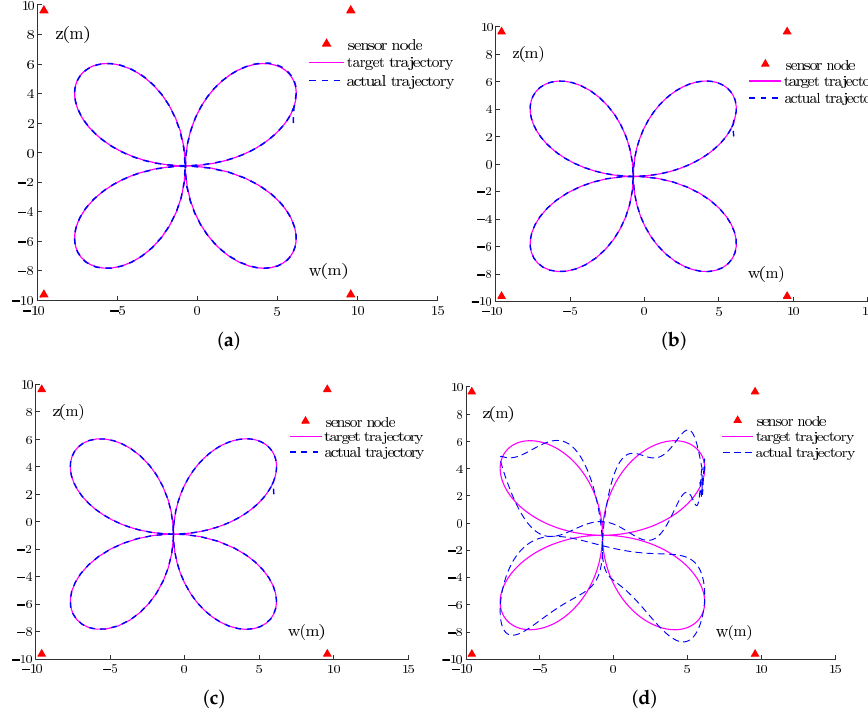
Figure 8. The target trajectories and actual trajectories by the two FPDP models, VPDP model and the pseudo-inverse method with noise η l ( t ) = sin ( 4 π t + π ) . ( a ) FPDP model with AF (5). ( b ) FPDP model with AF (10). ( c ) VPDP model with AF (12). ( d ) The pseudo-inverse method.